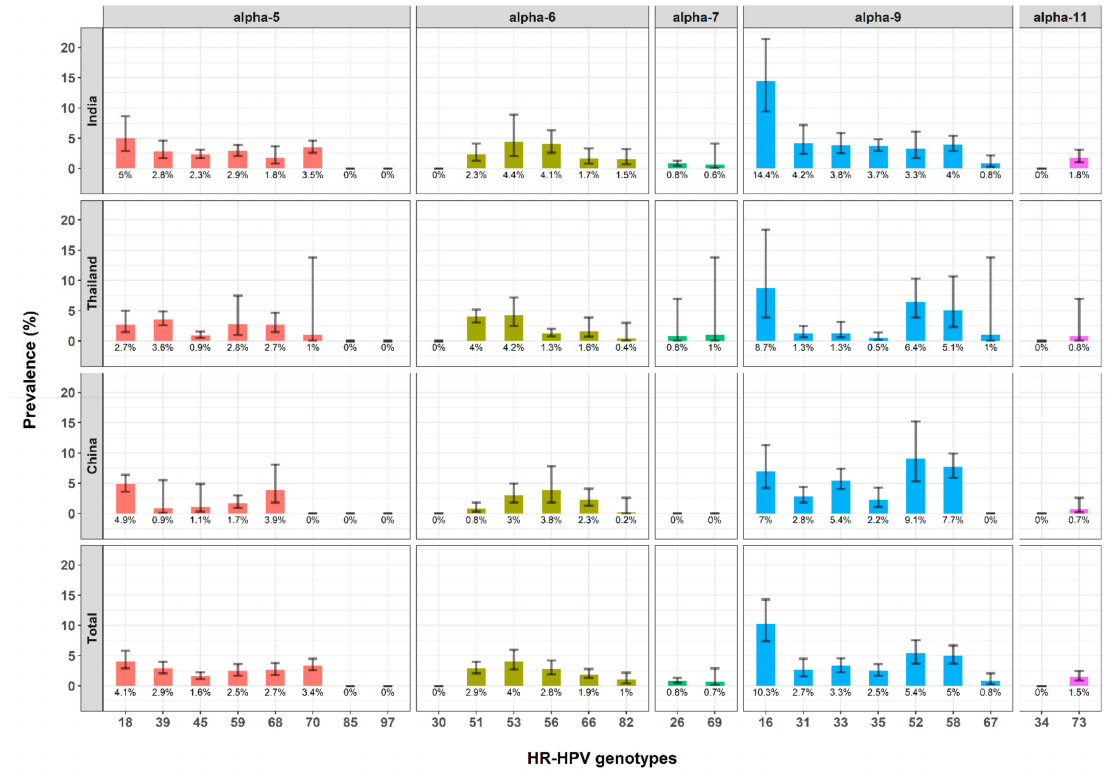
Figure 4. Prevalence of HR-HPV genotypes by country (China, India, and Thailand) and genus alpha group. HR-HPV: high-risk human papillomavirus. Each bar indicates the prevalence of the HPV genotype and its 95% confidence interval. Red bars for genus alpha-5 group, green bars for genus alpha-6, emerald green bars for genus alpha-7, blue bars for genus alpha-9, and purple bars for genus alpha-11.